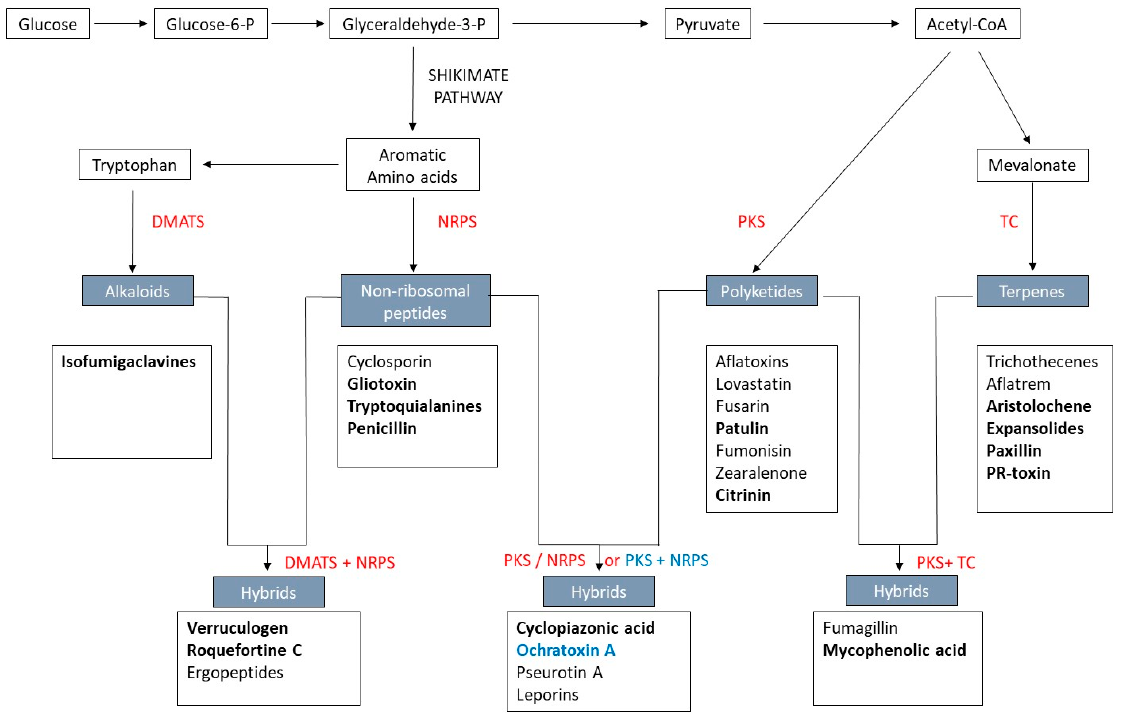
Figure 1. Biosynthetic pathways of secondary metabolites. In grey boxes, the typical backbone of secondary metabolites. In grey, the main mycotoxins produced by these pathways. In red, the enzymes associated with each pathway. In blue, separate PKS and NRPS are involved in ochratoxin A (OTA) biosynthesis; NRPS: non-ribosomal peptide synthetase, PKS: polyketide synthase, TC: terpene cyclase, DMATS: dimethylallyl tryptophan synthase. In bold, mycotoxins produced by Penicillium species.